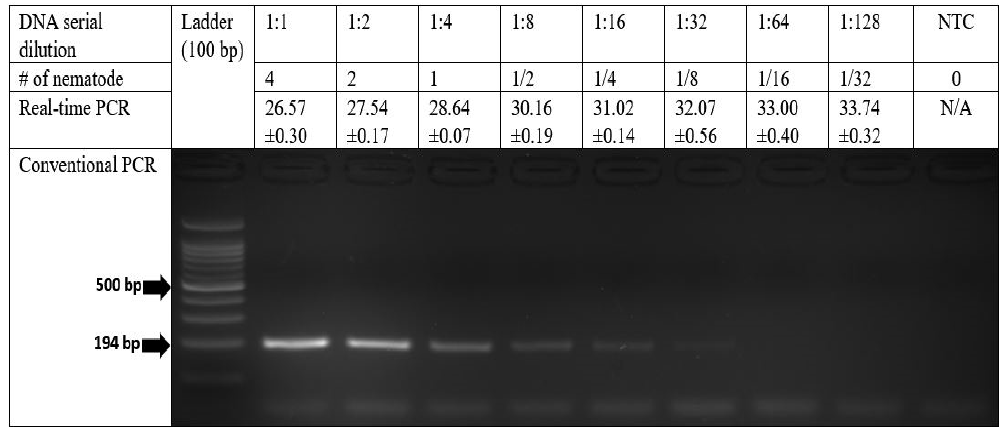
Figure 2. Amplification sensitivity of the IC-ITS1F/IC-ITS1R primer set in conventional polymerase chain reaction (PCR) compared to real-time PCR. The quantification cycle (Cq) value is presented as the mean ± standard deviation of three technical replicates of one of the biological replicates used for standard curve development. DNA was extracted from 4 P. dakotaensis individuals and sequential two-fold serial dilutions (2, 1, 1/2, 1/4, 1/8, 1/16, 1/32, and 1/64) were conducted, but the last dilution level 1:256 (1/64) was not included in this figure.